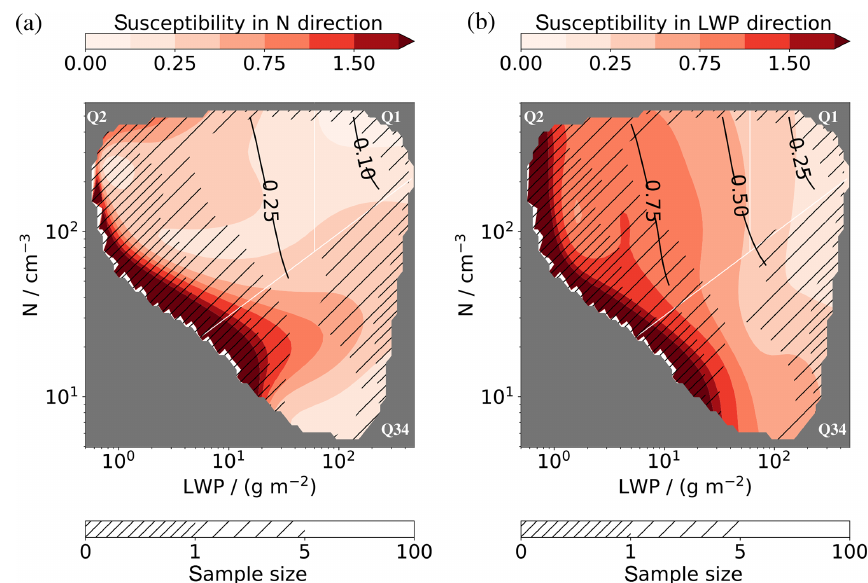
Figure 10. Partial susceptibilities of rCRE to (a) N and (b) LWP as a function of N and LWP as derived from the emulated rCRE surface (Fig. 5) (color contours). Solid lines show theoretical susceptibility values following Boers and Mitchell (1994), restricted to the nondrizzling region for which they apply. Hatching indicates the sample size as in Fig. 7. Note that sample sizes smaller than one trajectory can occur due to interpolation. White lines indicate quadrants as in Fig.